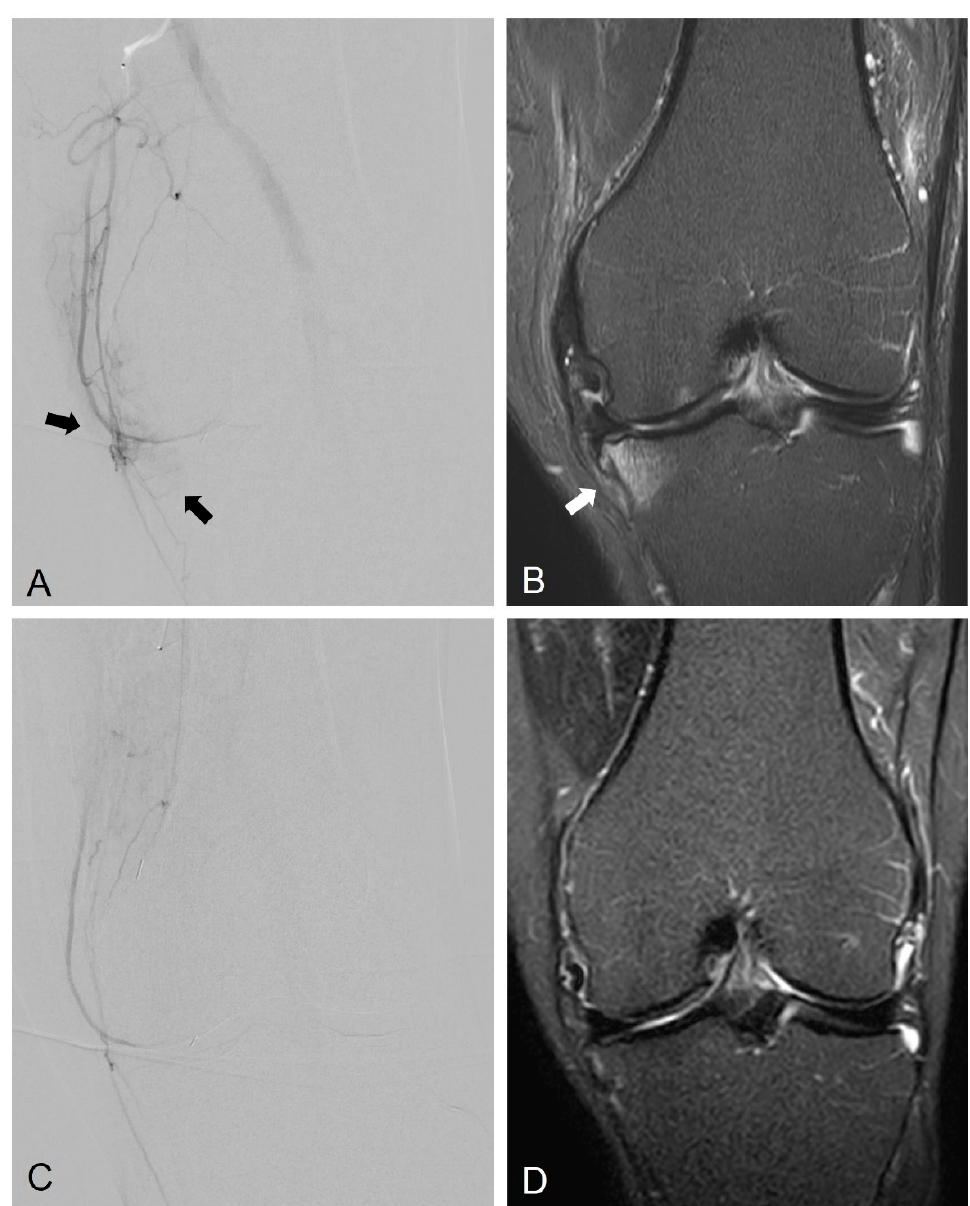
Figure 2. Representative pre- and postprocedural images of the right knee in a 69-year-old male with KL grade 2 osteoarthritis with associated pain. ( A ) Preprocedural angiography of the right descending genicular artery showed angiogenesis over medial aspect of the knee joint (black arrows). ( B ) Preprocedural coronal MRI (fat-saturated T2-weighted TSE) revealed subchondral bone marrow lesion over right tibia plateau (white arrow). ( C ) Postembolization angiography indicated elimination of angiogenesis after GAE. ( D ) Follow-up MRI acquired 3 months after GAE revealed the reduction of subchondral BML. The patient’s knee pain and function were improved after